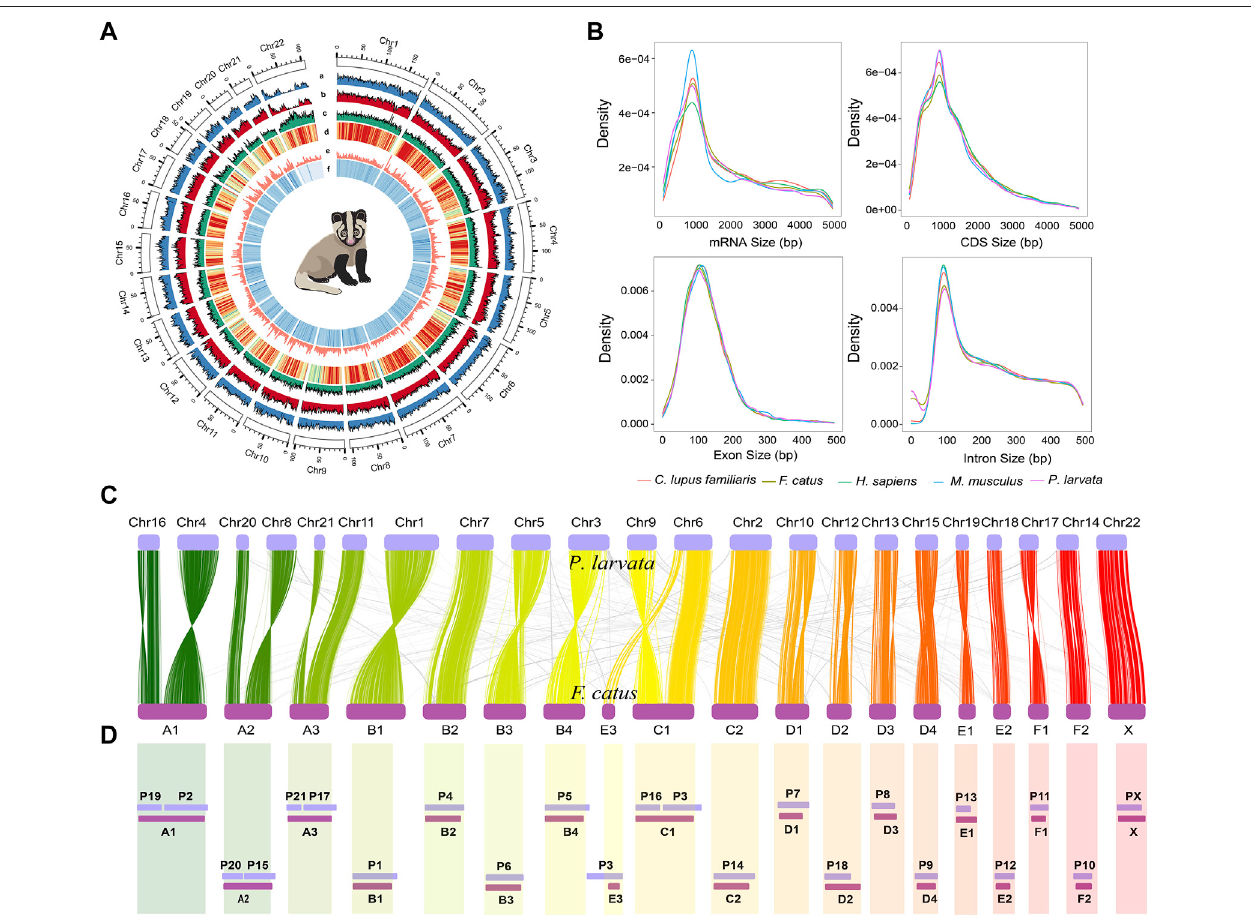
FIGURE 1 | Overview of P. larvata genome assembly and chromosome-level synteny analysis in this study. (A) Genomic features and variation landscape of our assembled genome (500 kb window). a, population-scale π -values across 22 chromosomes; b, SNP counts per 500 kb window; c, repeat density; d, GC content; e, gene density; f, read depth mapped to the genome. (B) Comparisons of mRNA length, coding sequence (CDS) length, exon length, and intron length among the fi ve species. The x-axis represents the length, and the y-axis represents the density. (C) Chromosome-level synteny analysis between P. larvata and F. catus , which was visualized using RectChr v1.27 (https://github.com/BGI-shenzhen/RectChr). (D) Schematic diagram of a comparative chromosome map of P. larvata (P chromosomes) and F. catus (A – F chromosomes) from previously published karyotypic study (Perelman et al., 2005). Lower bands represent the cat ’ s chromosomes, and the upper bands represent the masked palm civet ’ s chromosomes. All fi ssion and fusion events found in (C) can be correspondently found in (D) . We assume that thechromosomerelationshipsbetweenthecatand maskedpalmcivetwasaccurateinthekaryotypicanalysis,thenthehighlyconsistent resultbetweenkaryotypicand the syntenic analysis indicates the high quality of our assembled chromosome-scale